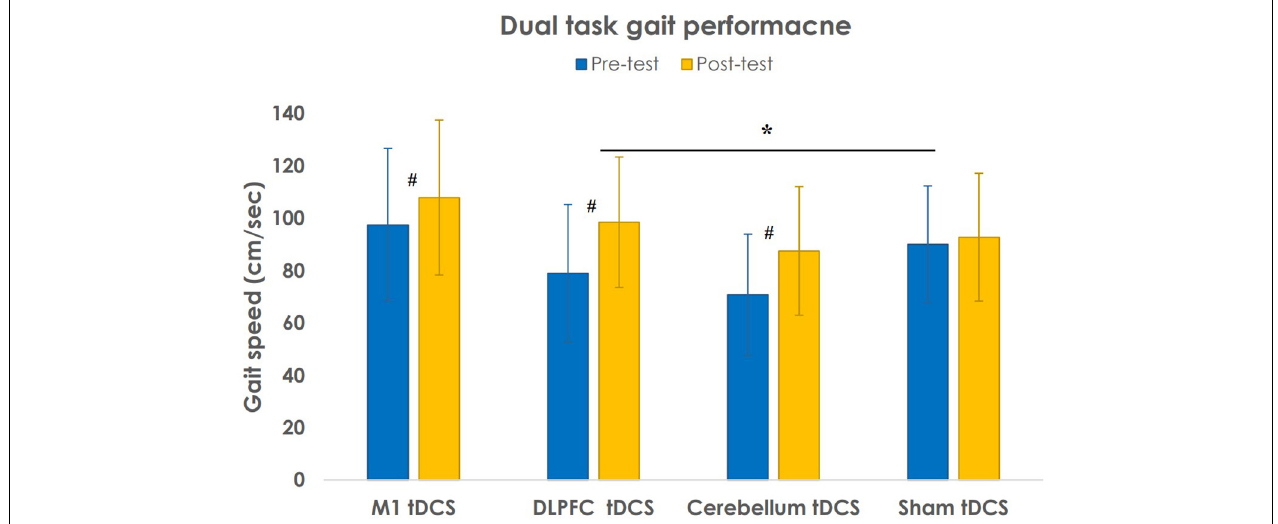
FIGURE 2 | Results of gait speed during dual-task walking performance after different transcranial direct current stimulation (tDCS) stimulations. Data are presented as the mean ± SD. # P < 0.05: intragroup comparison. * P < 0.05: intergroup comparison.